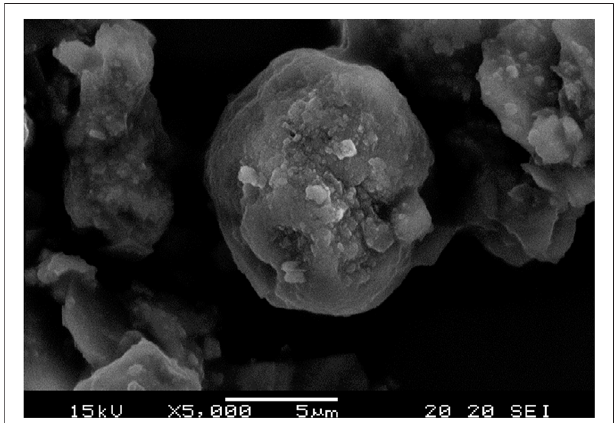
FIGURE 4 | SEM image of CaCO 3 :